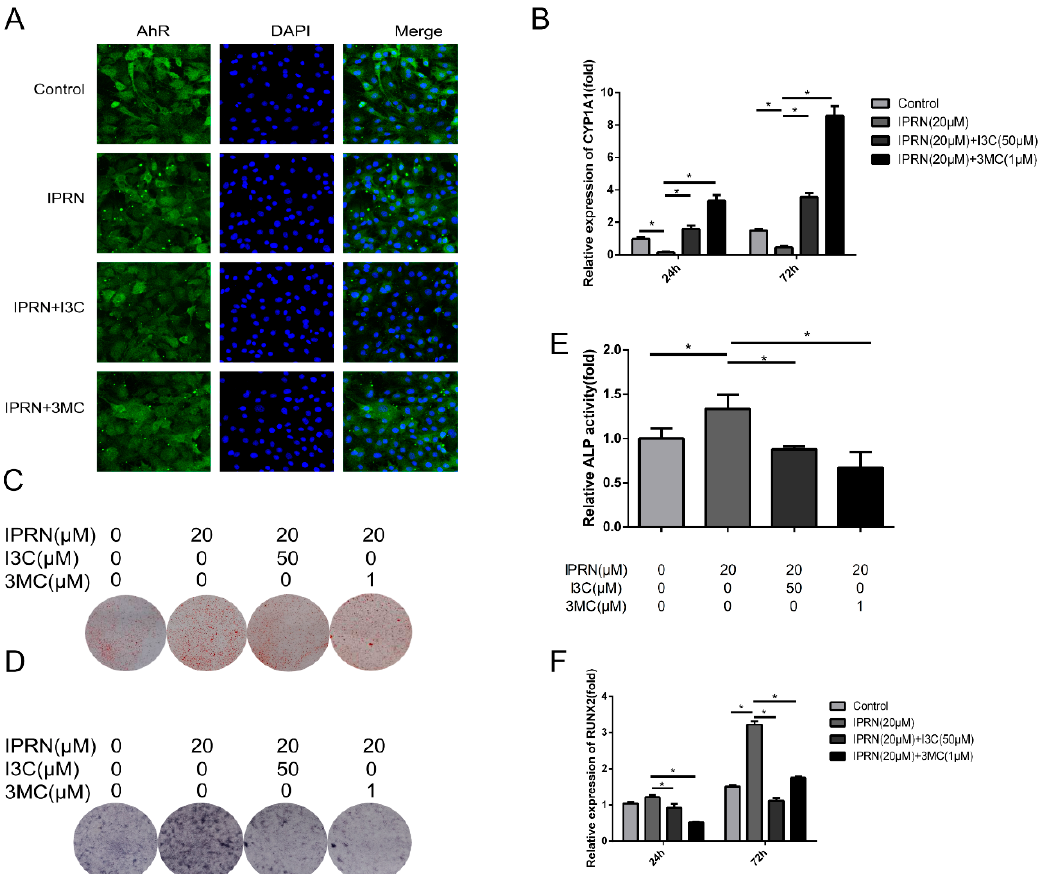
Figure 5. Effect of AhR agonists on IPRN-induced osteogenesis. The cells were cultured with I3C (50 µ M) or 3MC (1 µ M) in the presence of IPRN (20 µ M). ( A ) Immunofluorescence analysis of AhR was performed at 24 h. CYP1A1 ( B ) and RUNX2 (F) mRNA expression was assessed at 24 h and 72 h, respectively. Alizarin red ( C ) and ALP ( D ) staining was performed and ALP activity ( E ) was assessed on days 14 and 9, respectively. Data are presented as the mean ± SD ( n = 3). * p < 0.05.